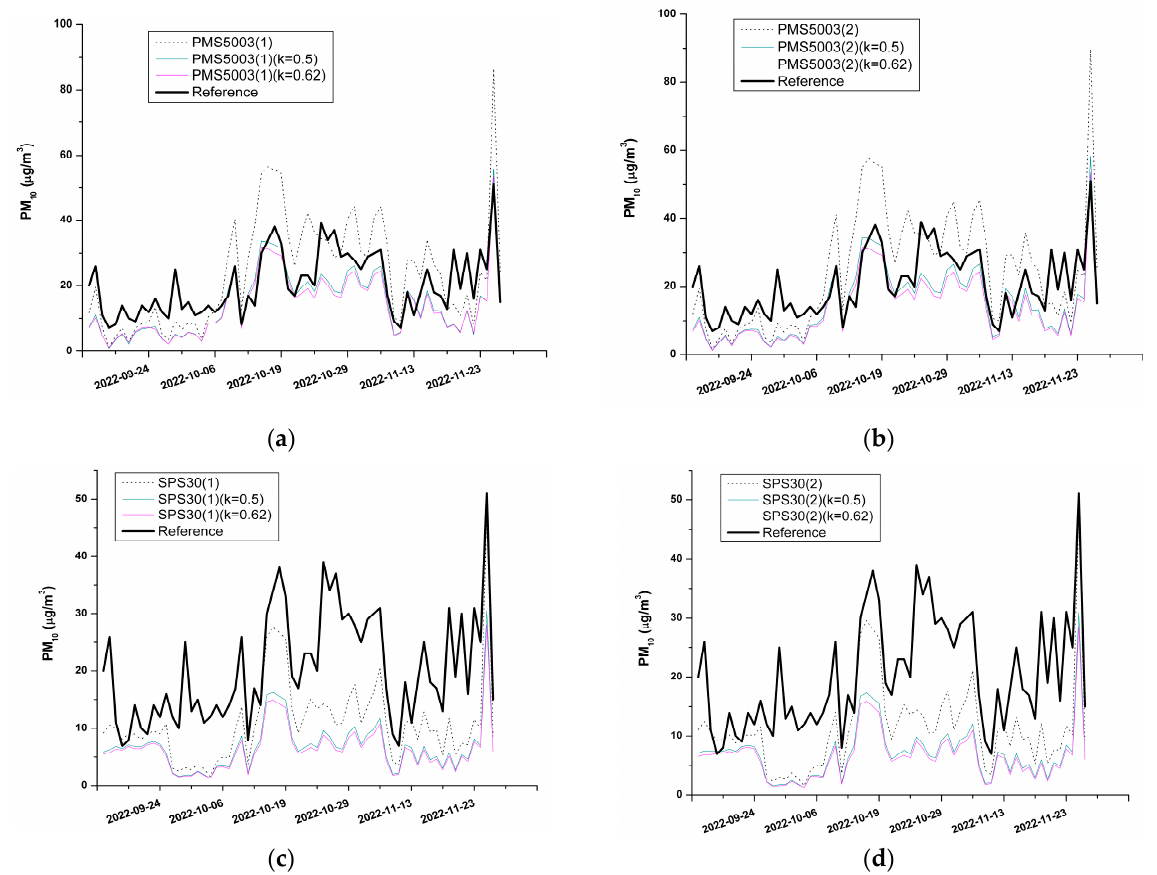
Figure 8. ( a ) PMS5003(1); ( b ) PMS5003(2); ( c ) SPS30(1); ( d ) SPS30(2). Time series of the sensor measurements compared with the reference device (thick black line). The dotted line is relative to the sensor data without the application of Equations (6) and (7). The straight thinner lines indicate the sensor measurements after applying the correction to include the humidity effect. The labels k = 0.5 and k = 0.62 indicate the different values of the “k” parameter in Equation